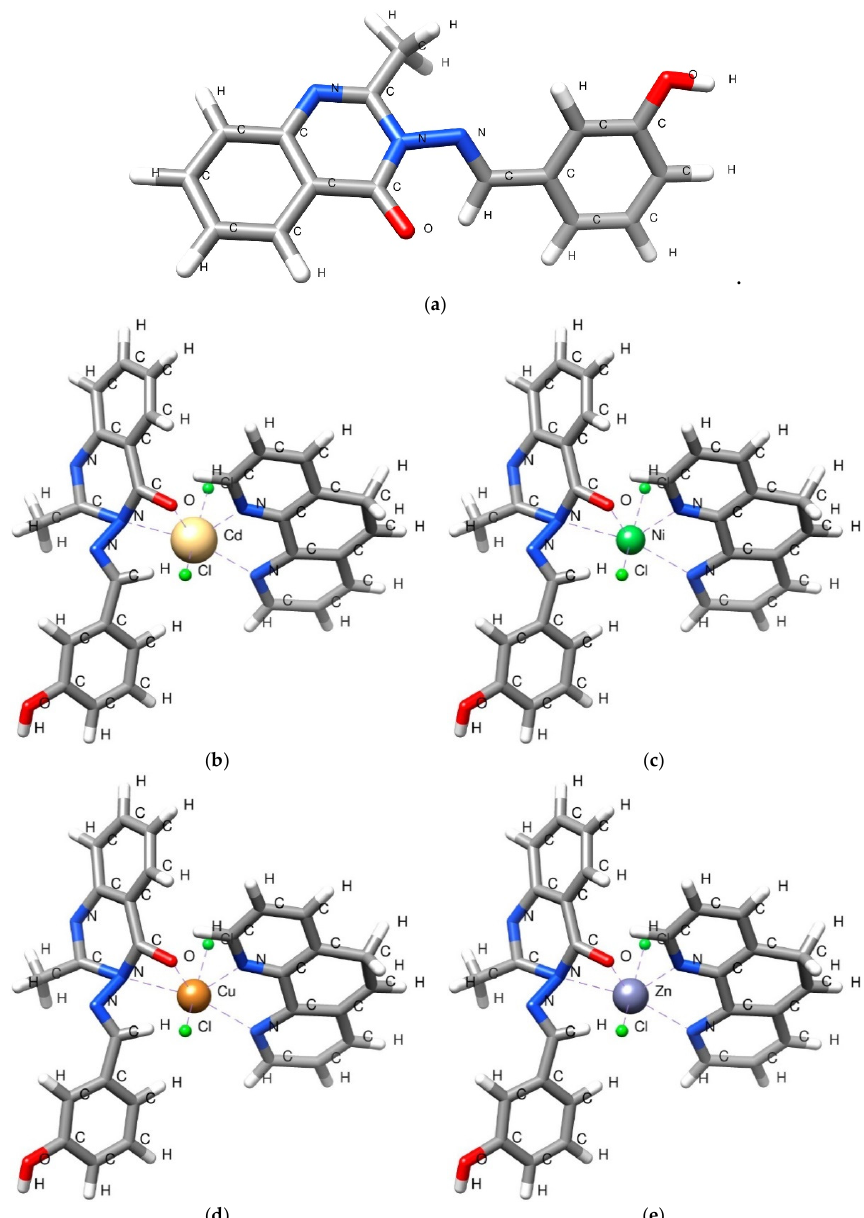
Figure 3. Optimized structures of ( a ) HMAQ , as well as ( b ) C 1 ( c ) C 2 , ( d ) C 3 , and ( e ) C 4 complexes. Table 3. The orbital energies of the highest occupied, lowest unoccupied, and singly occupied molecular orbitals (HOMO, LUMO, and SOMO), as well as the HOMO–LUMO (H–L) gap (all in eV) of the HAMQ ligand and its four metallic complexes; the J I , J A , J HL and ∆ SL descriptors were estimated with the aid of MN12SX / Def2TZVP / DMSO model chemistry. Compound HOMO LUMO SOMO H–L gap J